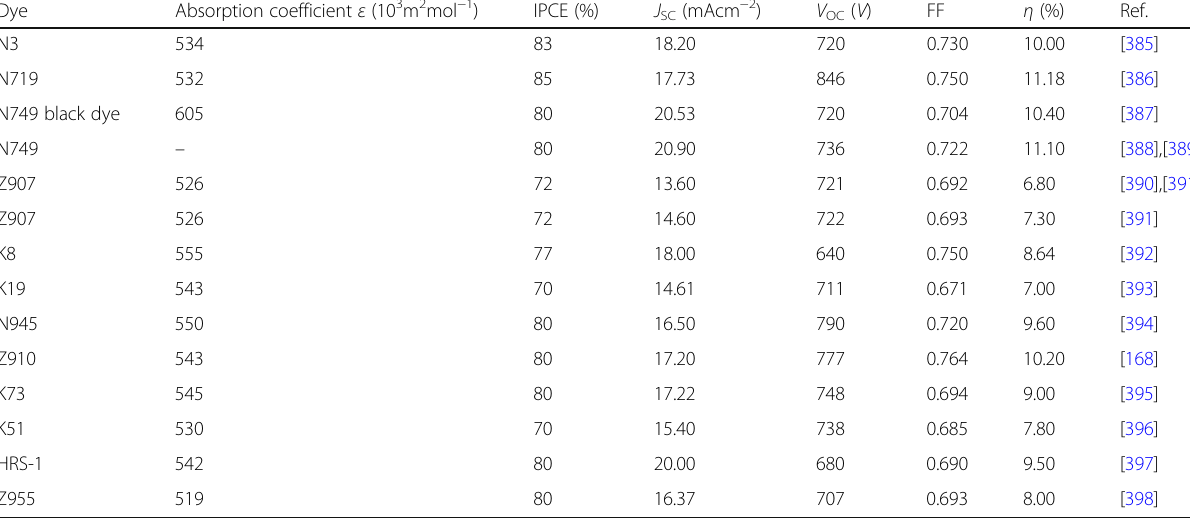
Table 3 Absorption spectra and photoelectric performance for DSSCs based on different metal complex [polypyridyl (RuII)] dyes